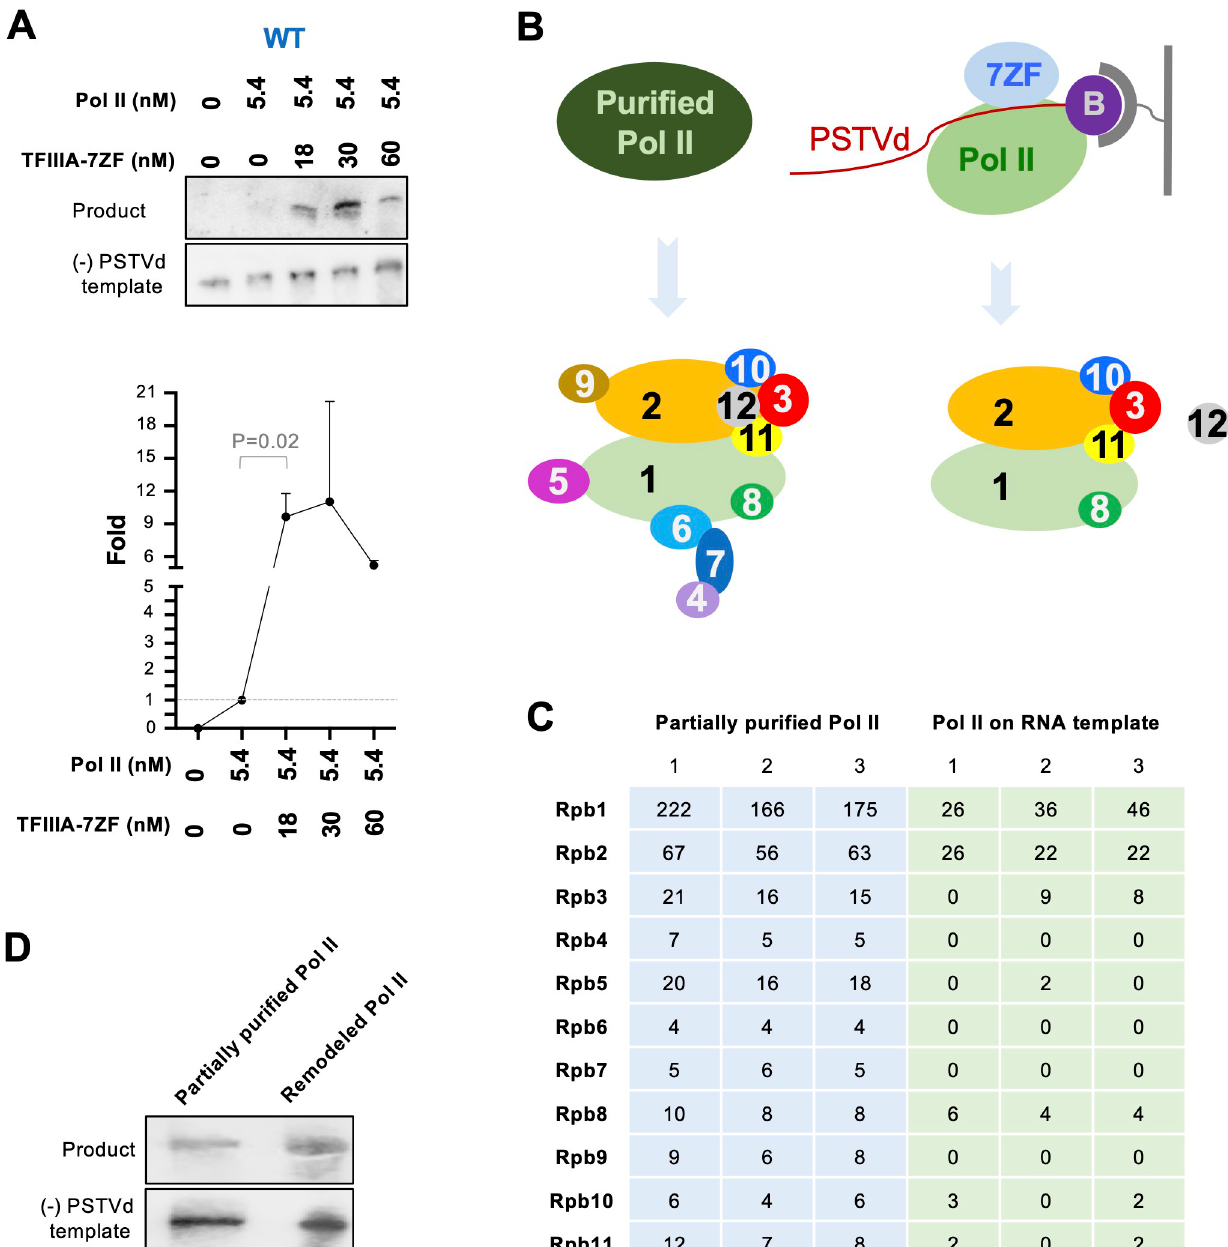
Fig 1. Uncovering the role of TFIIIA-7ZF and Pol II in transcribing (-) PSTVd oligomers. (A) Reconstituted in vitro transcription (IVT) system using partially purified Pol II (from wheat germ, 5.4 nM), (-) PSTVd dimer RNA (7.8 nM), and various amounts of TFIIIA-7ZF. Sequence-specific riboprobes were used to detect (-) PSTVd templates and (+) PSTVd products (at the position close to dimer PSTVd). Quantification of product intensities was performed using ImageJ. The first lane signal was set as 0 and the second lane signal was set as 1. Data from three replicates were used for graphing the fold increases induced by various amounts of TFIIIA-7ZF. The uncropped gel images are shown in S4 Fig. (B) Schematic presentation for RNA-based affinity purification followed by nLC-MS/MS identifying protein factors in partially purified Pol II and remodeled Pol II. The presence of Rpb12 in the partially purified Pol II is based on literature. It remains to be determined whether Rpb12 is in the remodeled Pol II. (C) Peptide counts for each Pol II subunit in all nLC-MS/MS replicates. The summarized nLC-MS/MS data are listed in S1 Table. The original data can be found in S1–S6 Datasets. (D) IVT assay demonstrating the activity of remodeled Pol II. The first lane contains free RNA as template, while the second lane contains mixed free RNA and desthiobiothnylated RNA as template. The reaction condition is described in Methods in detail.